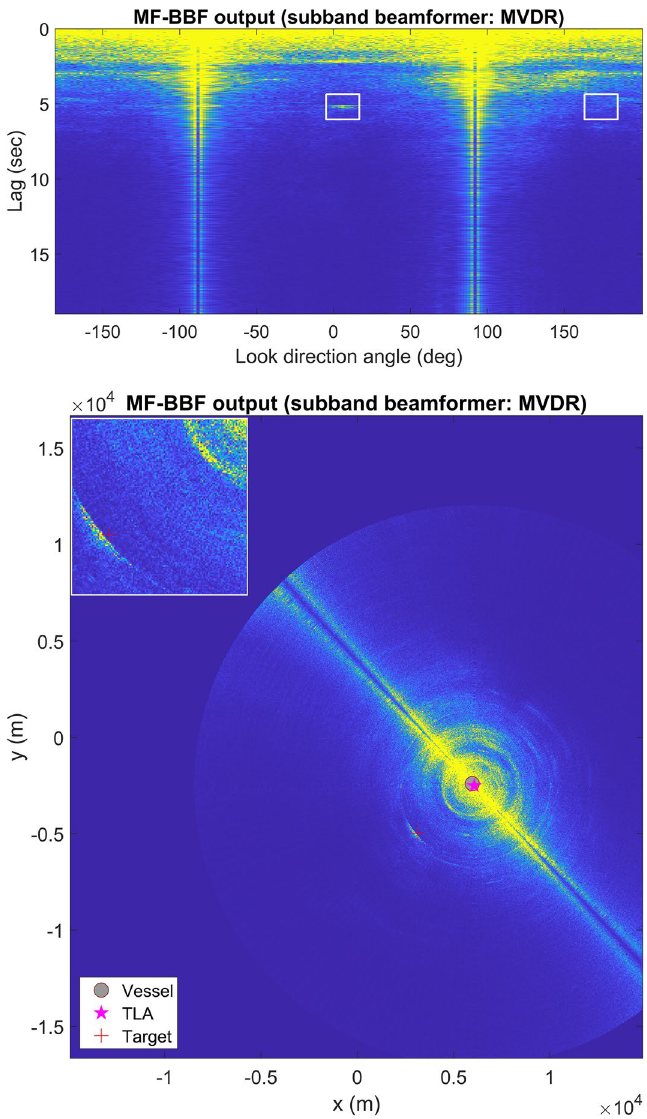
Fig. 10 Processing outputs obtained for LCAS’16 data; the subband beamformer used: MVDR. The upper left corner of the lower display shows an image obtained by zooming in on the target